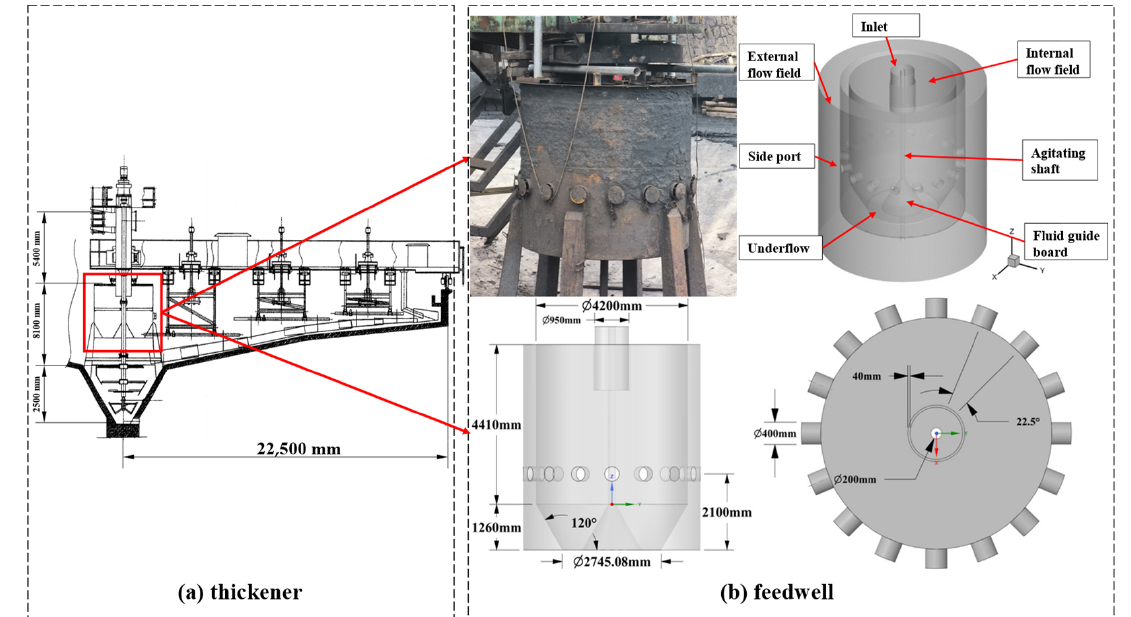
Figure 1. Structure of the central feedwell of the thickener, ( a ) Dimensional and structural drawings of the thickener in the vertical plane; ( b ) Size and structure of the feedwell in the thickener ( a ).